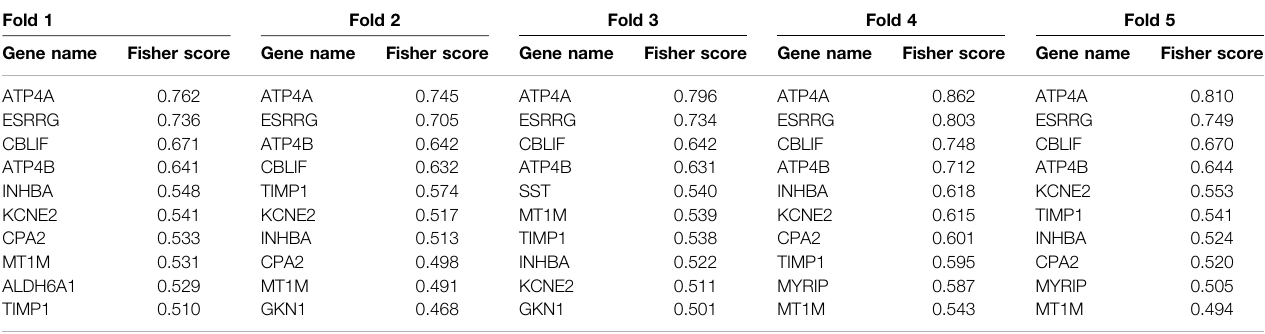
TABLE 1 | All genes and their Fisher Scores were selected by the feature algorithm. Fold 1 Fold 2 Fold